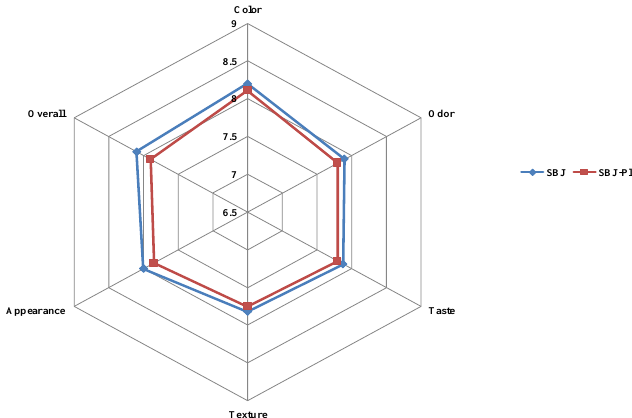
Figure 7. Spider plot of the sensory analysis of sea buckthorn juice. SBJ, sea buckthorn juice; SBJ-Pl, sea buckthorn juice fermented with Lactobacillus plantarum.